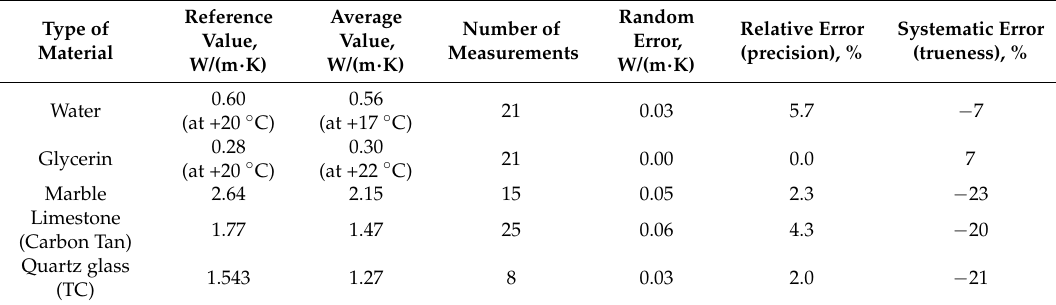
Table 2. Precision and trueness of KD-2 thermal conductivity